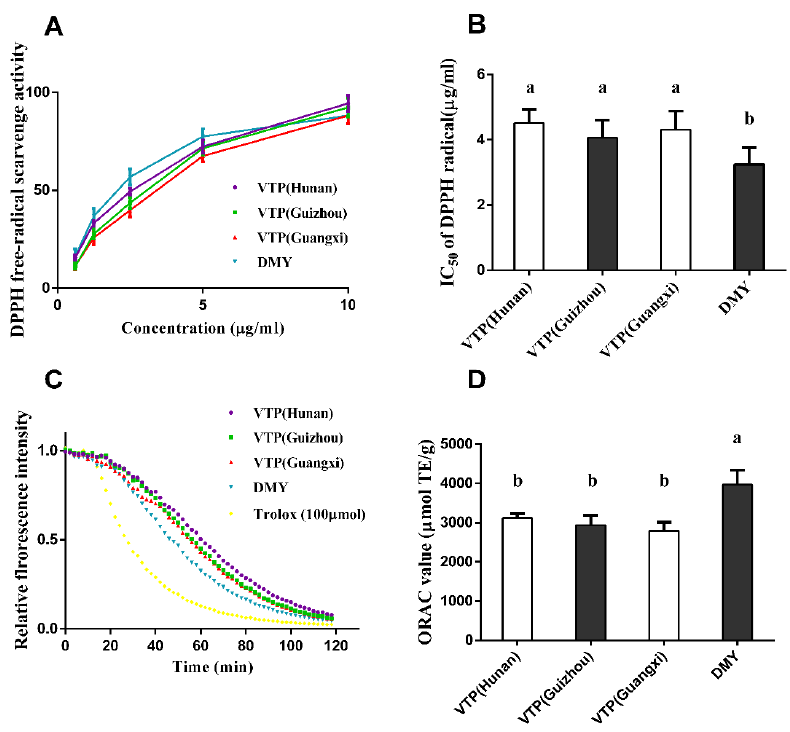
Figure 4. Antioxidant ability of VTP. ( A ) 2,2-diphenyl-1-picrylhydrazy (DPPH) free-radical scavenging rate of VTP from three locations and DMY. ( B ) IC 50 value of the DPPH free-radical scavenging of VTP from three locations and DMY. ( C ) Relative florescence intensity of oxygen radical absorbance capacity (ORAC) of VTP from three locations and DMY in 2 h. ( D ) ORAC value (Trolox equivalent/g sample) of VTP from three locations and DMY. The data represent mean ± SD with three repeats, different letters in the same bar indicate significant differences ( p < 0.05).